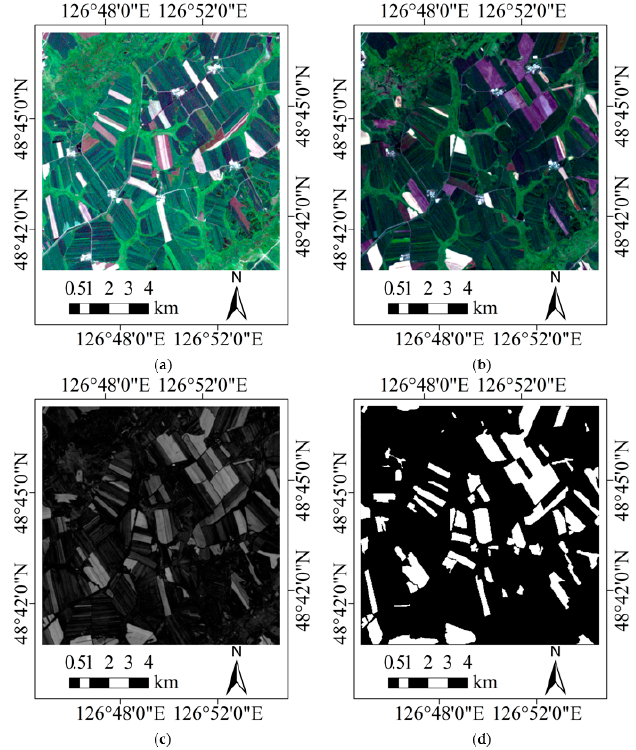
Figure 3. True color images of data set 1 acquired by Landsat-7 ETM+ in ( a ) August 2001 and ( b ) August 2002; ( c , d ) are the difference image and reference image, respectively.